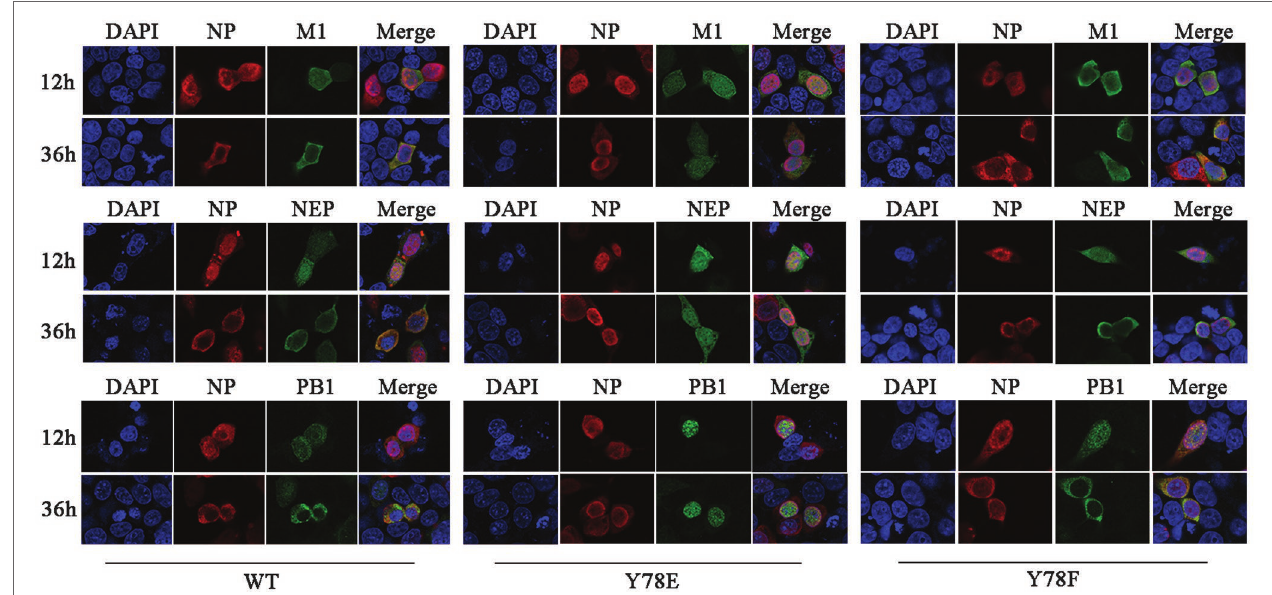
FIGURE 5 | Y78 phosphorylation status regulates the nuclear export of NEP-M1-vRNP complex. The co-localizations of NP with M1/NEP/PB1 were examined by IFAs. The 12-plasmid reverse genetic system containing WT, Y78F, or Y78E NP plasmid was transfected into 293 T cells. At 12 and 36 h.p.t., cells were fixed and stained with anti-NP (red) and anti-M1/NEP/PB1 antibodies (green). The nucleus was stained with DAPI